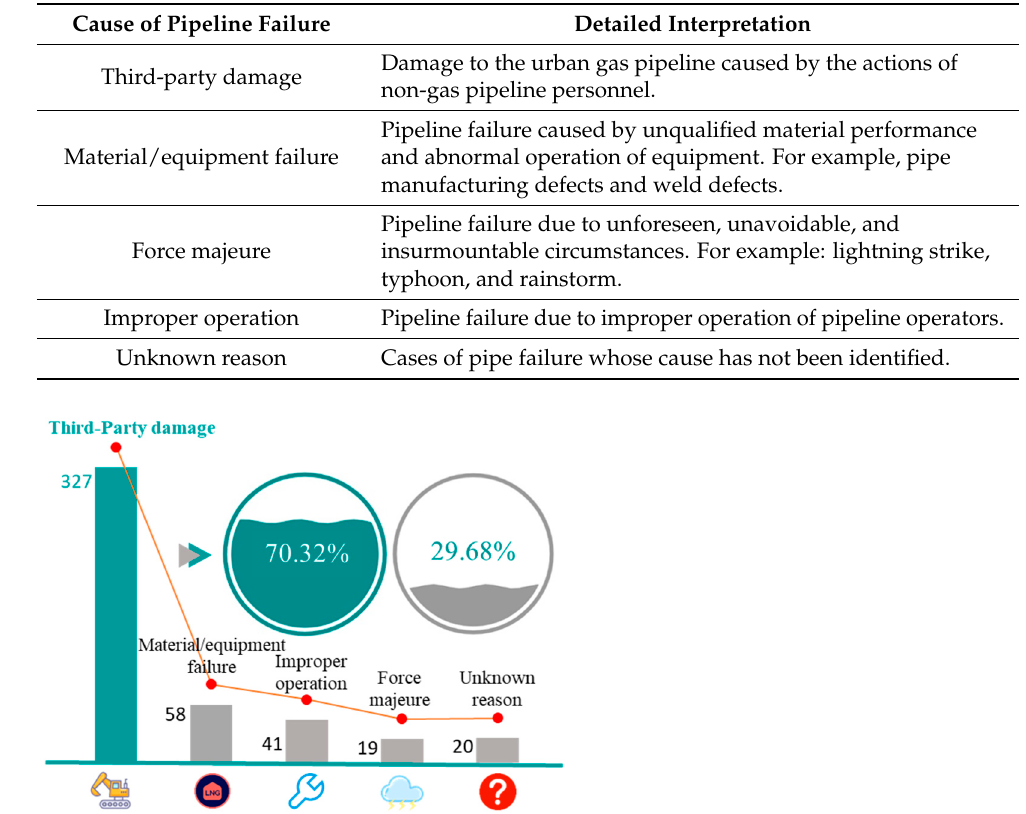
Table 2. Major hidden dangers of urban gas PE pipelines (cause of pipeline failure).